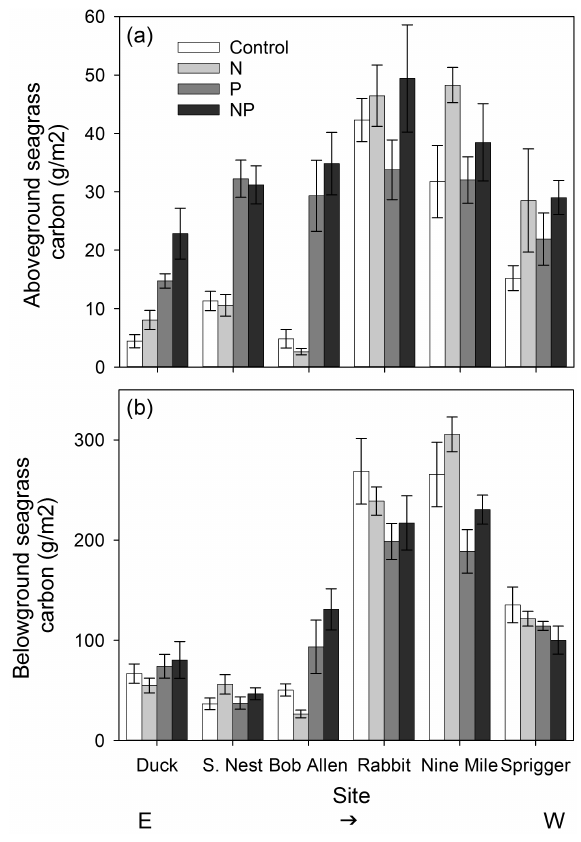
Figure 2. (a) Aboveground and (b) belowground seagrass carbon stocks at six sites in response to nitrogen (N) and phosphorus (P) ad- dition. Sites are displayed along a naturally occurring P-availability gradient from low P availability in the east to high P availability in the west.